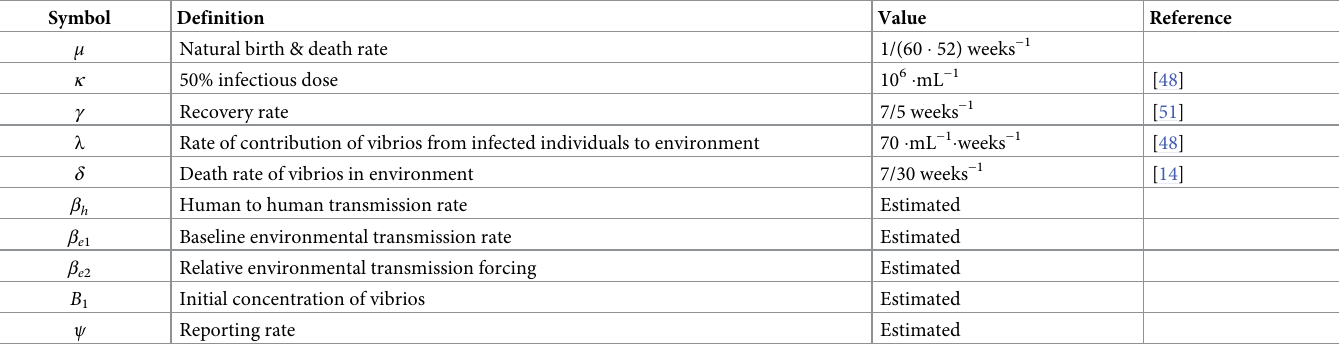
Table 1. Parameter definitions and baseline values associated with the mechanistic cholera transmission